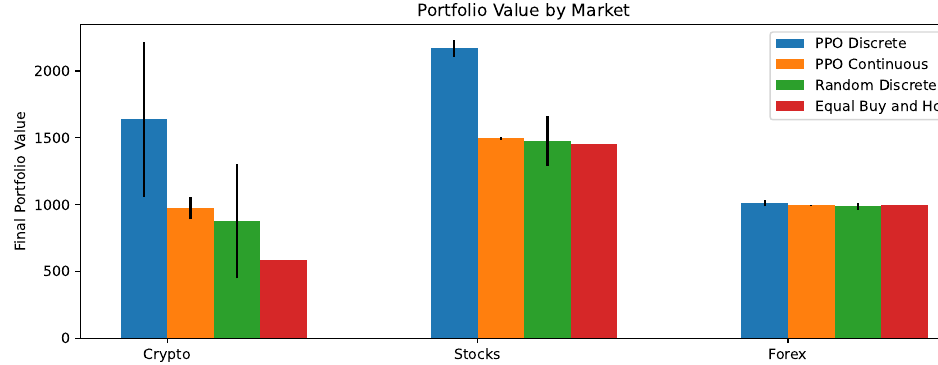
Figure 5. Portfolio value by